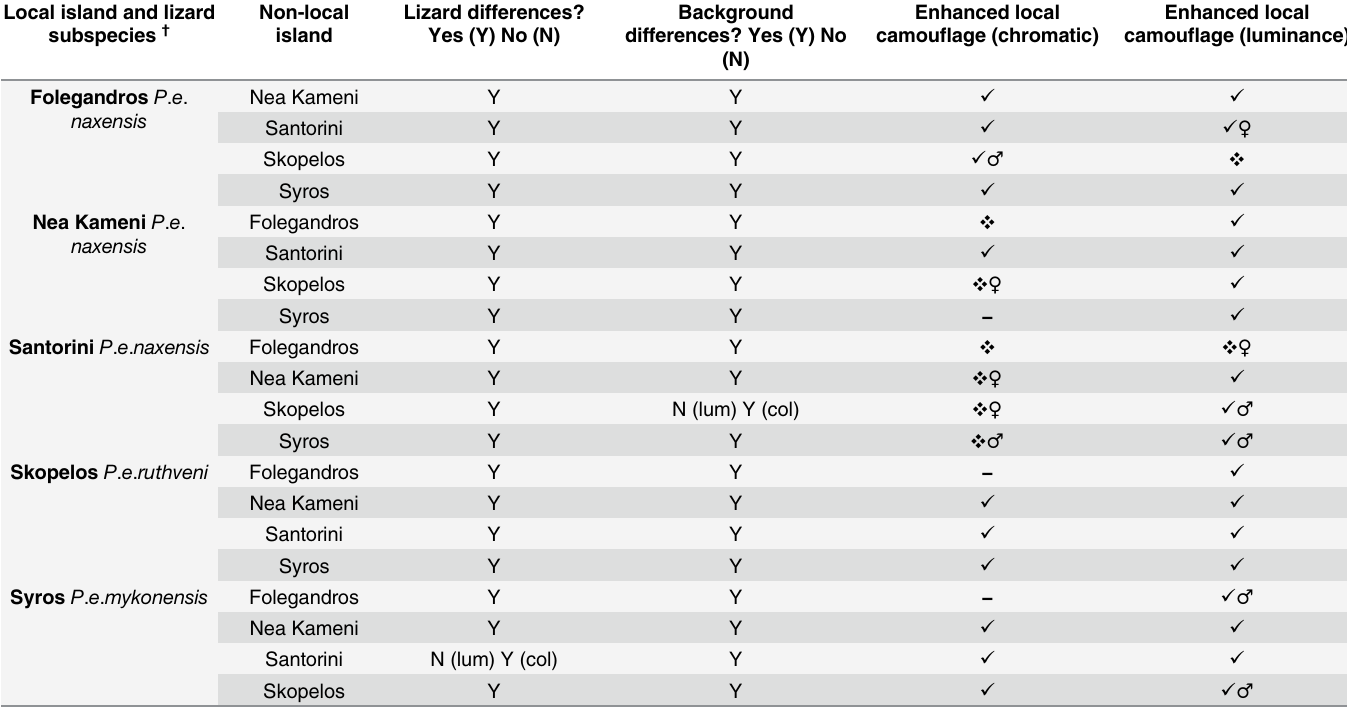
Table 2. Occurrence of enhanced local camouflage in Aegean wall lizards ( Podarcis erhardii ). Enhanced local matching was verified when lizards ’ dor- sal regions matched their local island backgrounds better than other non-local island backgrounds in terms of chromatic and luminance background matching (JND) to avian predators (see main text and table footnotes for symbol definitions). Lizard and background differences refer to significant differences in degree of contrast (JND) and in colour ( hue and saturation ) and luminance (see main text) between local and non-local islands. Local island and lizard subspecies